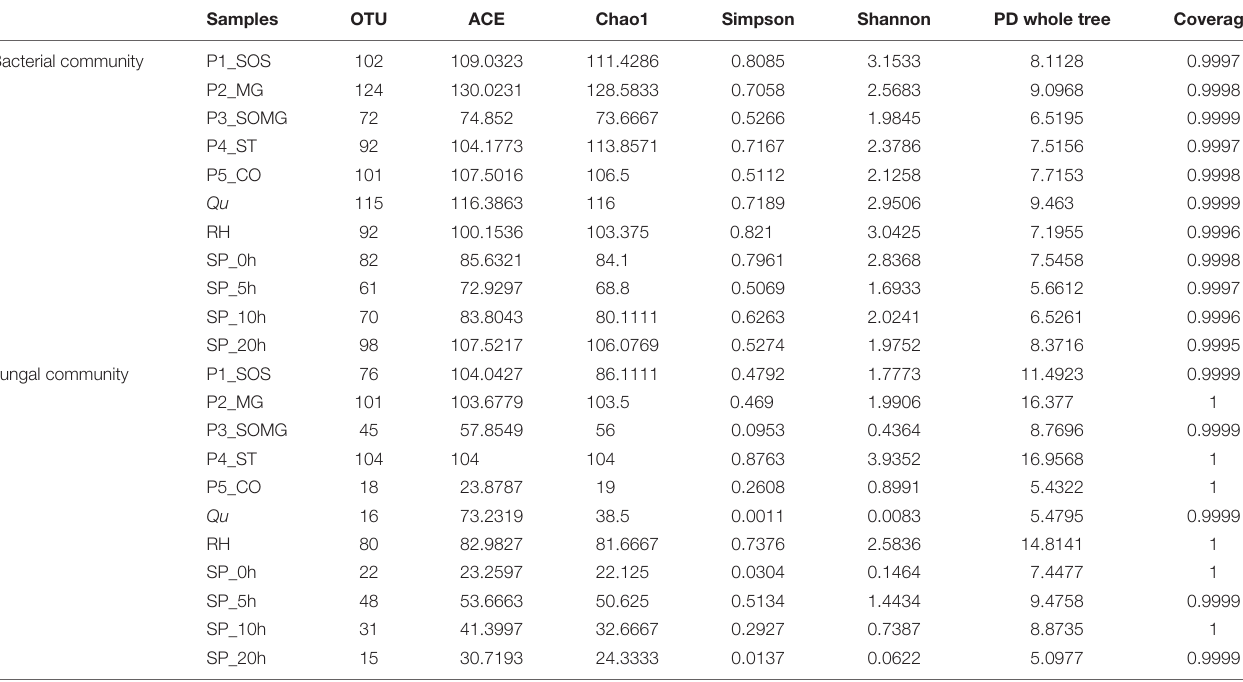
TABLE 1 | Observed operational taxonomic units (OTUs), richness indices (ACE and Chao1), diversity indices (Simpson and Shannon), phylogenetic diversity (PD whole tree), and Good’s coverage of microbial community. Samples OTU ACE Chao1 Simpson Shannon PD whole tree